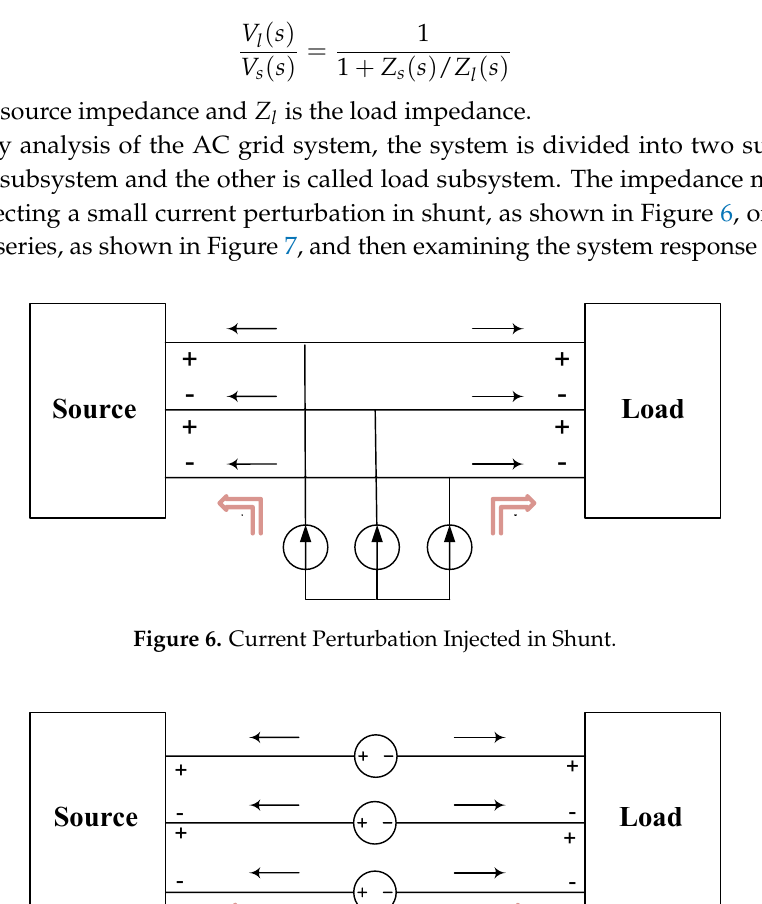
Figure 5. Simplified Power System as Feedback Control System.